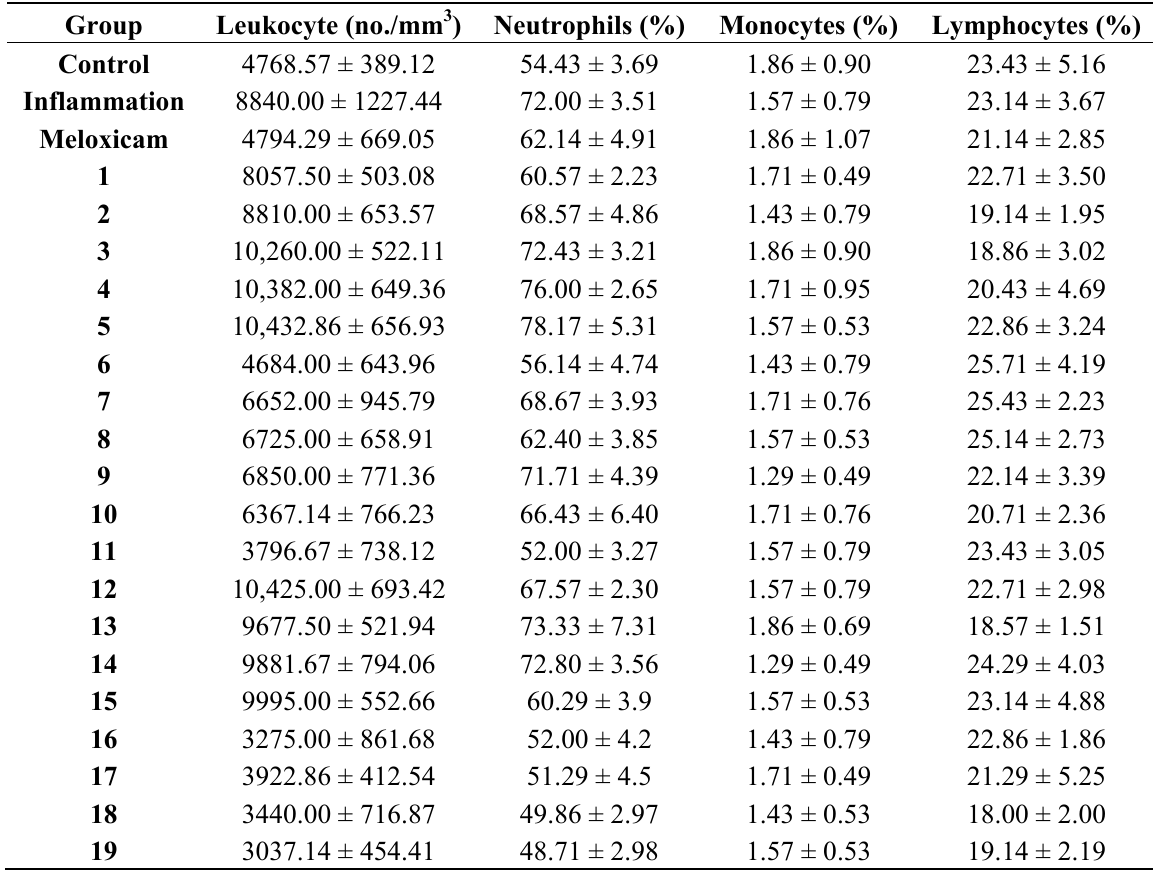
Table 1. The effects of the bisthiazoles on the acute phase bone marrow response.